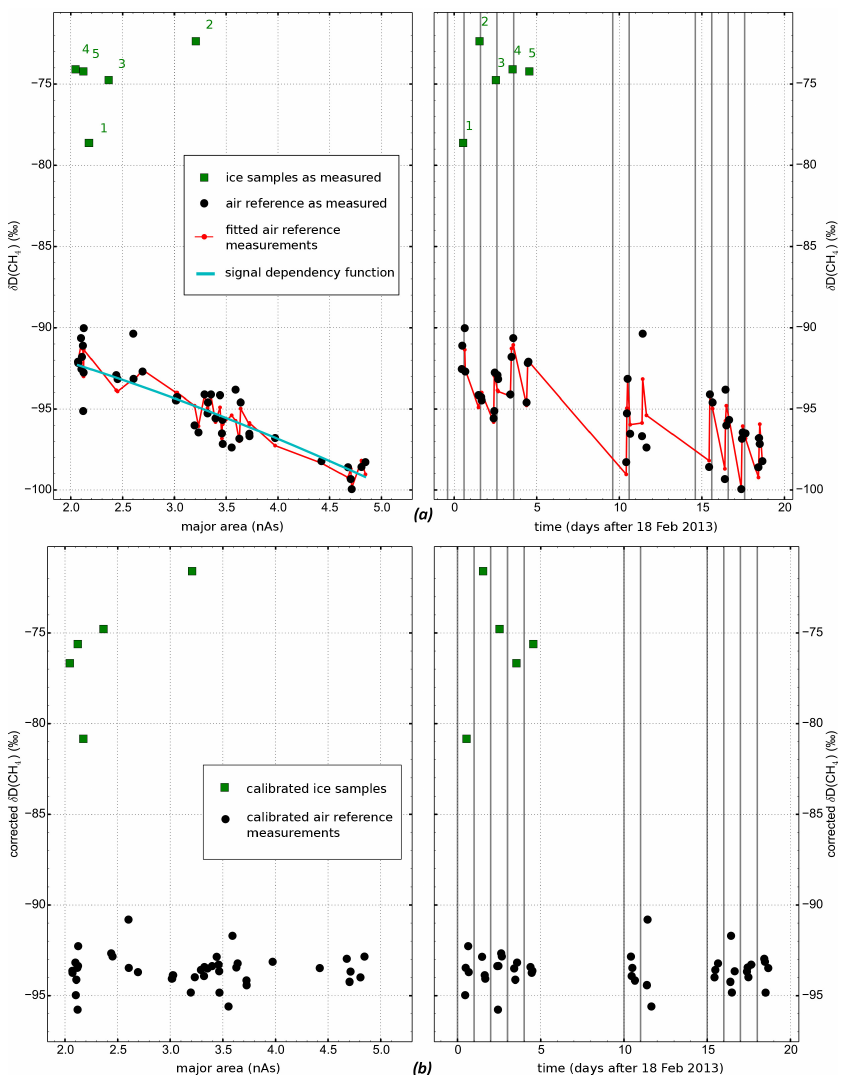
Figure 3. (a) Top panels: uncalibrated δ D(CH 4 ) data of our reference Air Controlé (black bullets) and B34 ice core samples (green squares). The left panel shows δ D(CH 4 ) vs. major area, i.e. the observed signal dependency including temporal drift. The right panel shows the same uncalibrated data set plotted against time. The red dots and line show the fitted standard numbers, which are later used to calibrate the samples, as described in the Appendix. The closer the red and black symbols are to each other, the better the fit. The cyan line indicates the polynomial correction function for signal dependency. (b) Bottom panels: calibrated δ D(CH 4 ) data of Fig. 3a after correction for temporal drift and signal dependency using the software described in the Appendix. The left panel shows δ D(CH 4 ) vs. major area and the right panel shows the same calibrated data set plotted against time. Black bullets show standard measurements (Air Controlé); green squares show B34 ice core